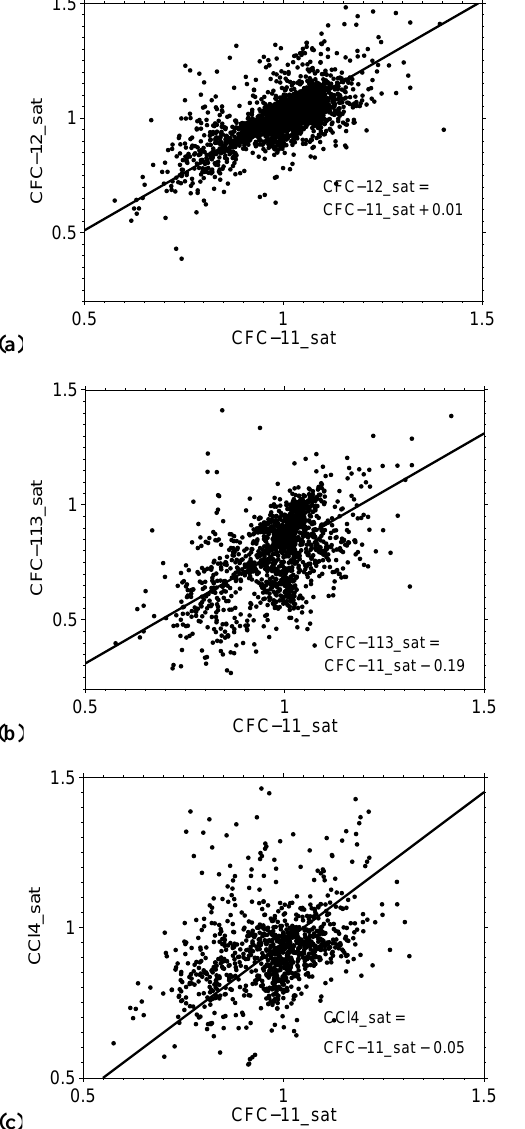
Figure 6 Figure 6. Correlation of surface saturation between: (a) CFC- 12 / CFC-11, (b) CFC-113 / CFC-11, and (c) CCl 4 / CFC-11 for all cruises that have been included into the 2nd QC for the Atlantic region.